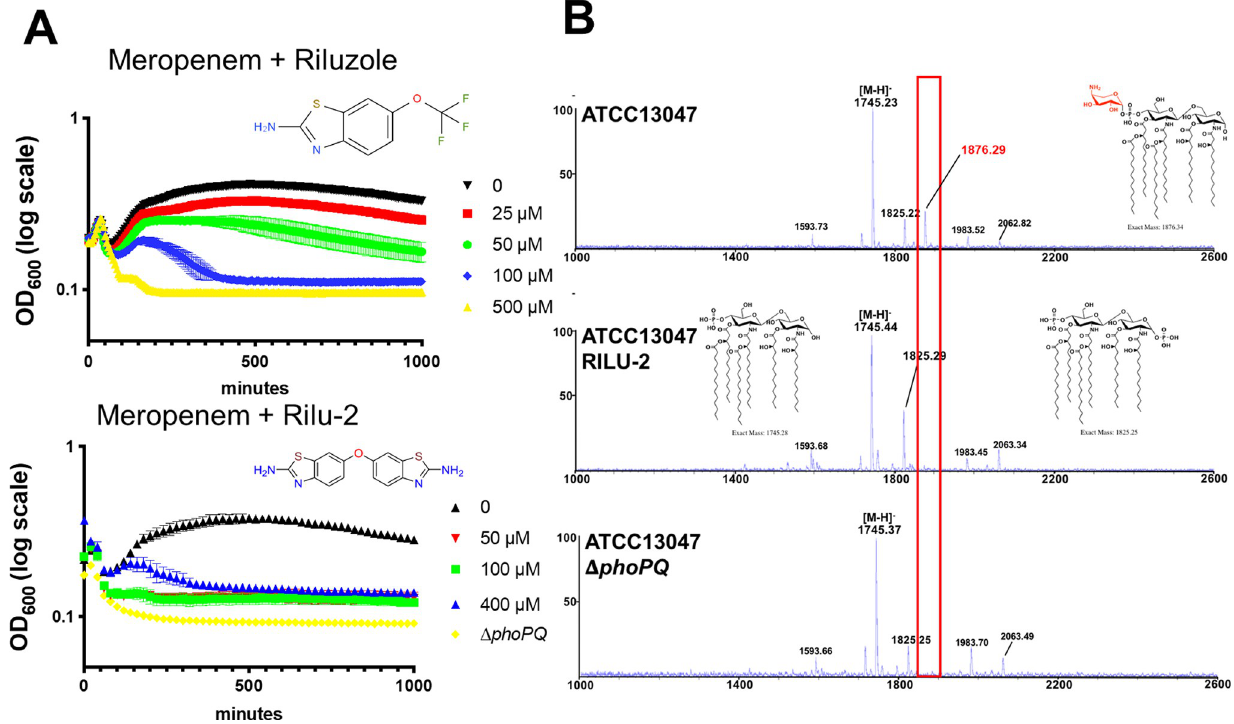
Fig 7. Rilu compounds synergize with meropenem to expedite E . cloacae killing. (A) Rilu compounds potentiate meropenem-induced lysis against E . cloacae . Overnight cultures were diluted 10-fold into fresh growth medium containing meropenem (10 μ g/mL) and increasing concentrations of Riluzole or its derivative Rilu-2. Data represent the average of 3 technical replicates +/- standard deviation. (B) MALDI-MS analysis of lipid A isolated from untreated wild-type E . cloacae , cells treated with RILU-2 or Δ phoPQ . m/z corresponding with L-Ara4N modifications are illustrated in red. Relevant lipid A chemical structures are shown. Each experiment was independently replicated three times, and one representative data set is reported.